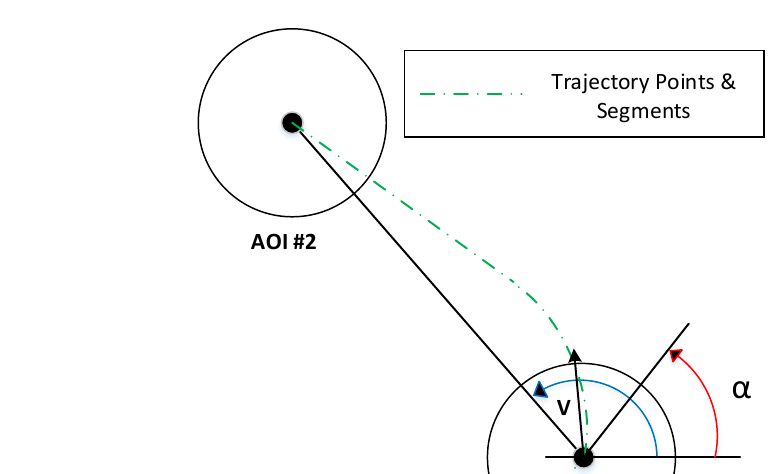
Figure 2. Fly over path planner flowchart.